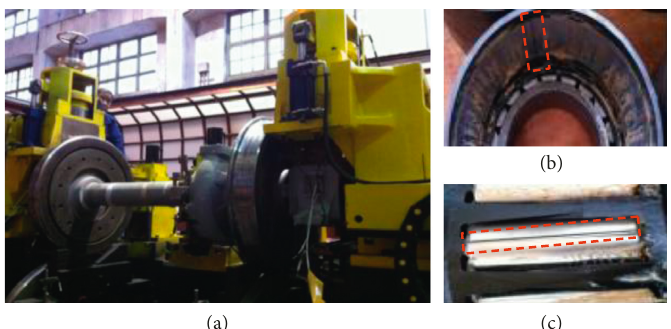
Figure 15: The test bench for investigating wheelset bearing faults and bearing defects: (a) bench; (b) outer-race defect; (c) roller defect.